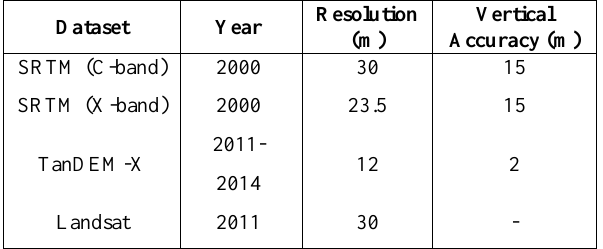
Table 1. Dataset specifications